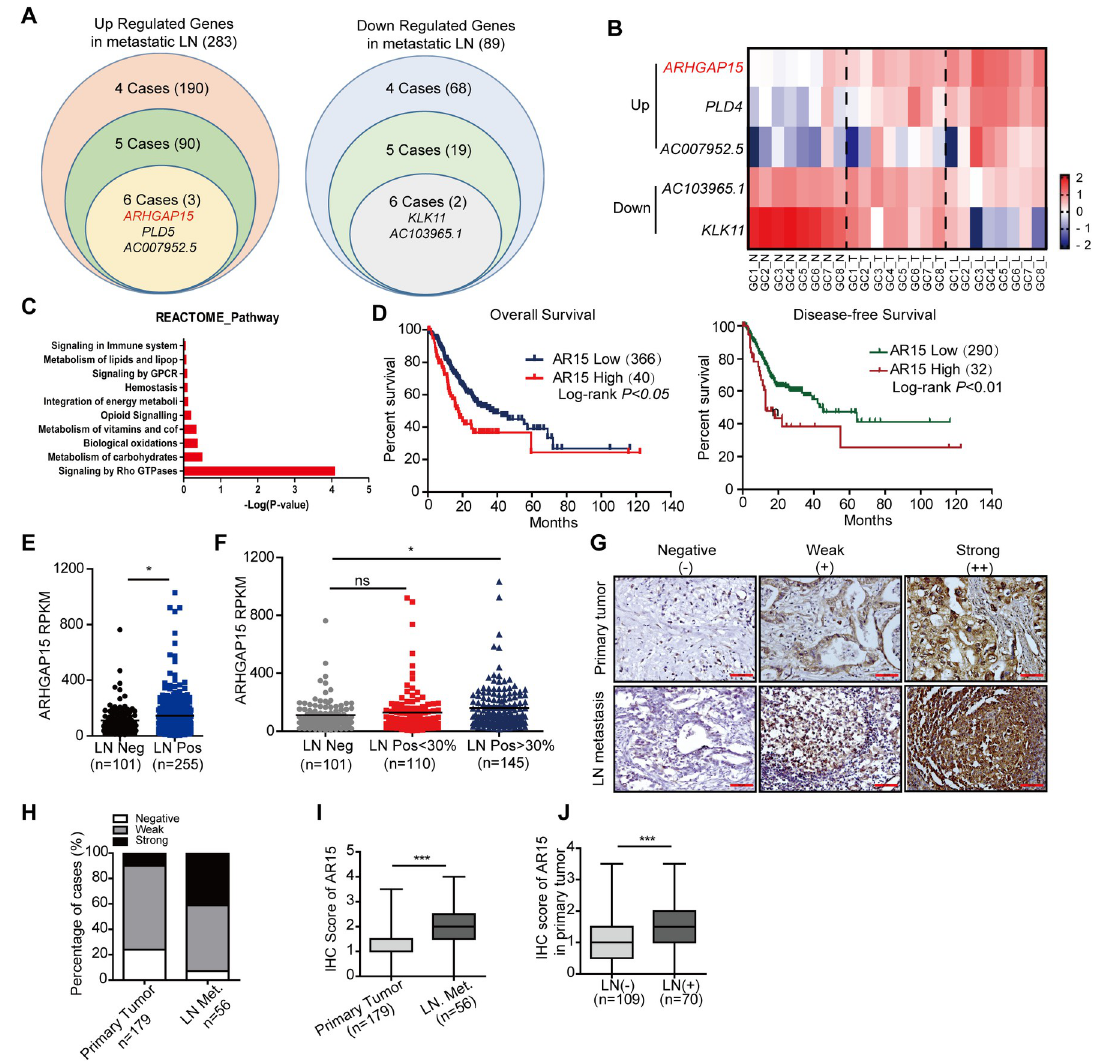
Fig 1. ARHGAP15 was identified as a leading upregulated gene in the metastatic lymph nodes. (A) : Differentially expressed genes in metastatic lymph nodes (LN) were identified. The frequently LN metastatic-dysregulated genes which appeared in at least 6 out of 8 cases were shown. (B) : Heatmap showed the 3 leading up-regulated and 2 down-regulated genes in LN Met. (C) : GO analysis indicated that dysregulated genes in LN metastasis were enriched in Rho GTPase signaling pathway. (D) : Based on TCGA data, ARHGAP15 expression was associated with unfavorable overall survival and disease-free survival. (E) : Based on TCGA data, ARHGAP15 expression was up-regulated in LN metastasis positive group than the negative group. (F) : Comparison of ARHGAP15 expression between the group without LN metastasis, the group whose metastatic LNs was less than and over 30% of total. (G-J) : TMA analysis suggested ARHGAP15 level was upregulated in metastatic lymph nodes. G: The ARHGAP15 negative staining (score 0), weak positive staining (score 0.5–2.5) and strong positive staining (score 3–4) were shown in primary tumor and LN metastasis respectively. H: The histogram showed the proportion of cases with negative staining, weak positive staining and strong positive staining in the primary tumor and LN metastasis respectively. I: ARHGAP15 was significantly up-regulated in the LN metastasis than primary tumor tissue. J: ARHGAP15 was up-regulated in the primary tumor of the cases with LN metastasis. ns: no significance; � , P < 0.05; �� , P < 0.01; ��� , P <